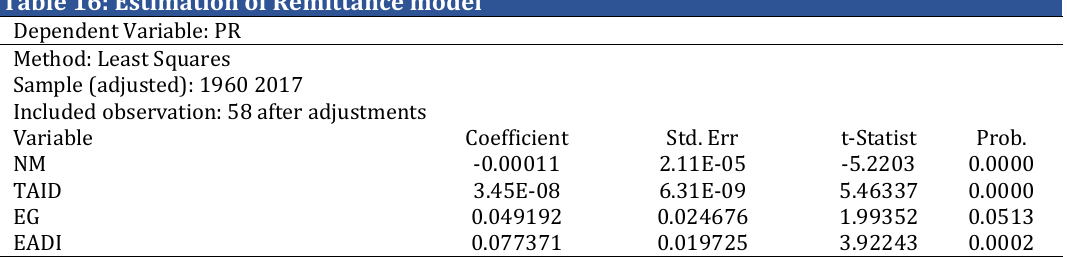
Table 16: Estimation of Remittance